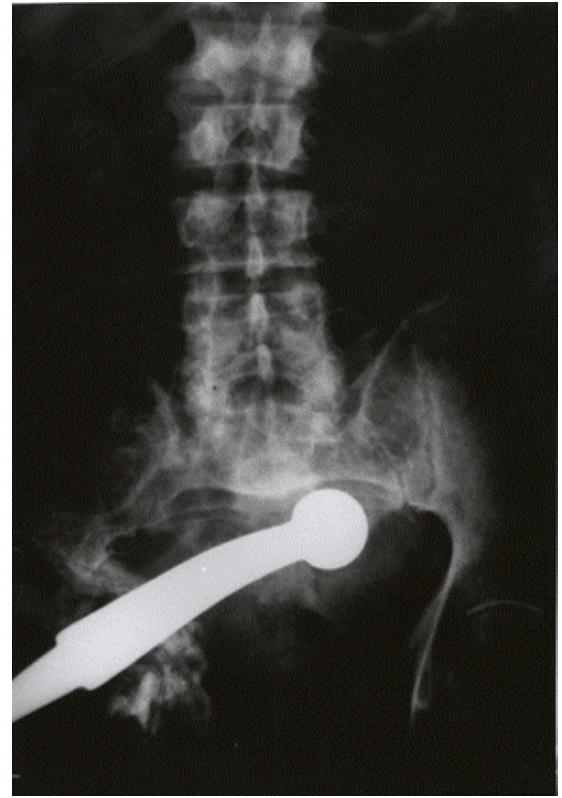
Figure 1. Plain radiograph of the pelvis with the transpelvically dislocted prosthetic stem (anterior-posterior view)